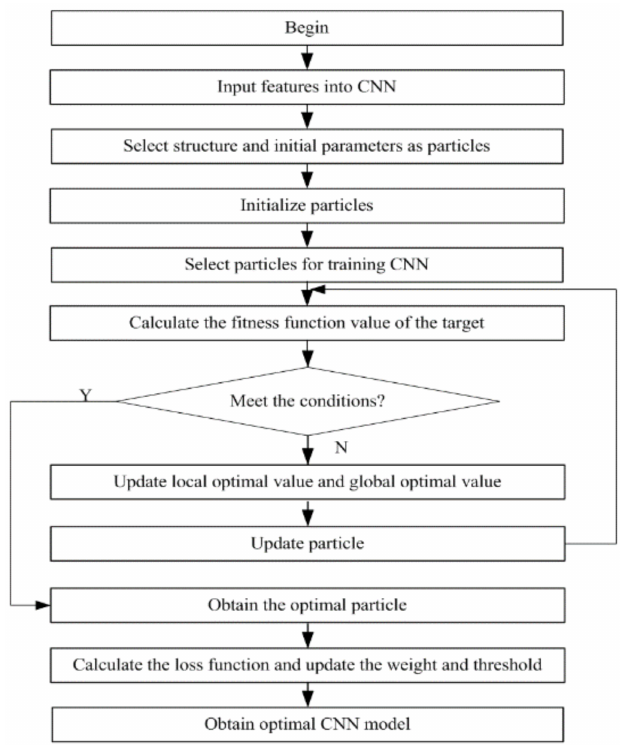
Figure 3. The optimization process of the CNN using